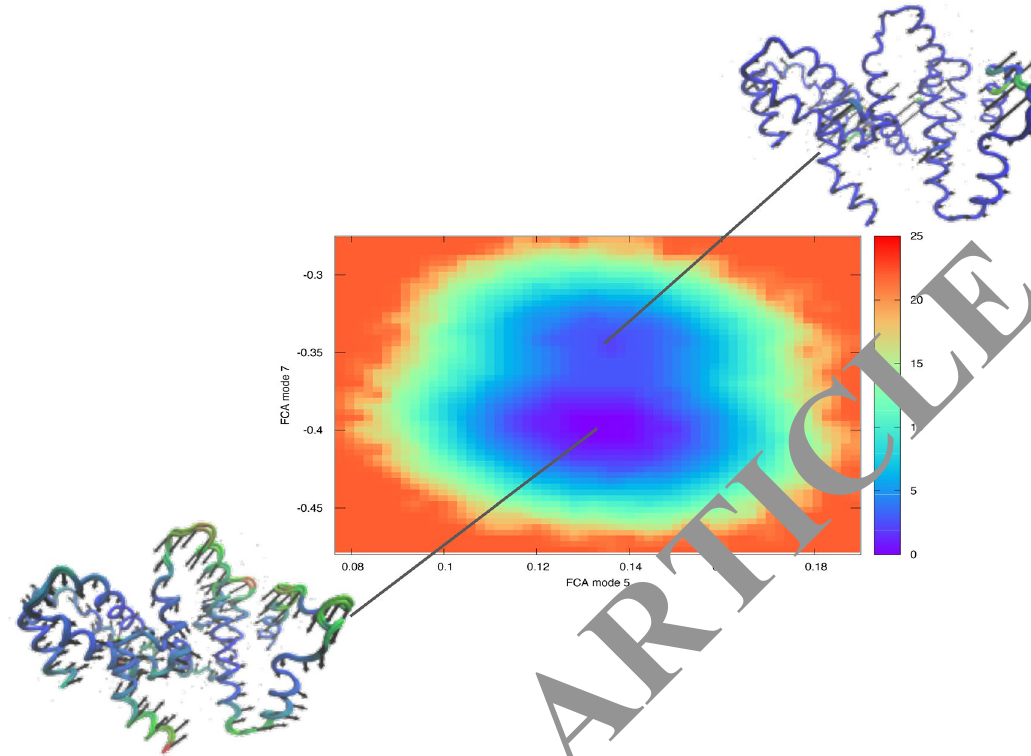
Figure 2. Free energy surface derived from the full correlation analyses (FCA) of the MD trajectories of the IFN - γ dimer. The C-a representation of IFN - γ illustrates the dominant motion within the minimum of the energy surfaces where regions colored in red show greater mobility and regions in blue have less mobility.